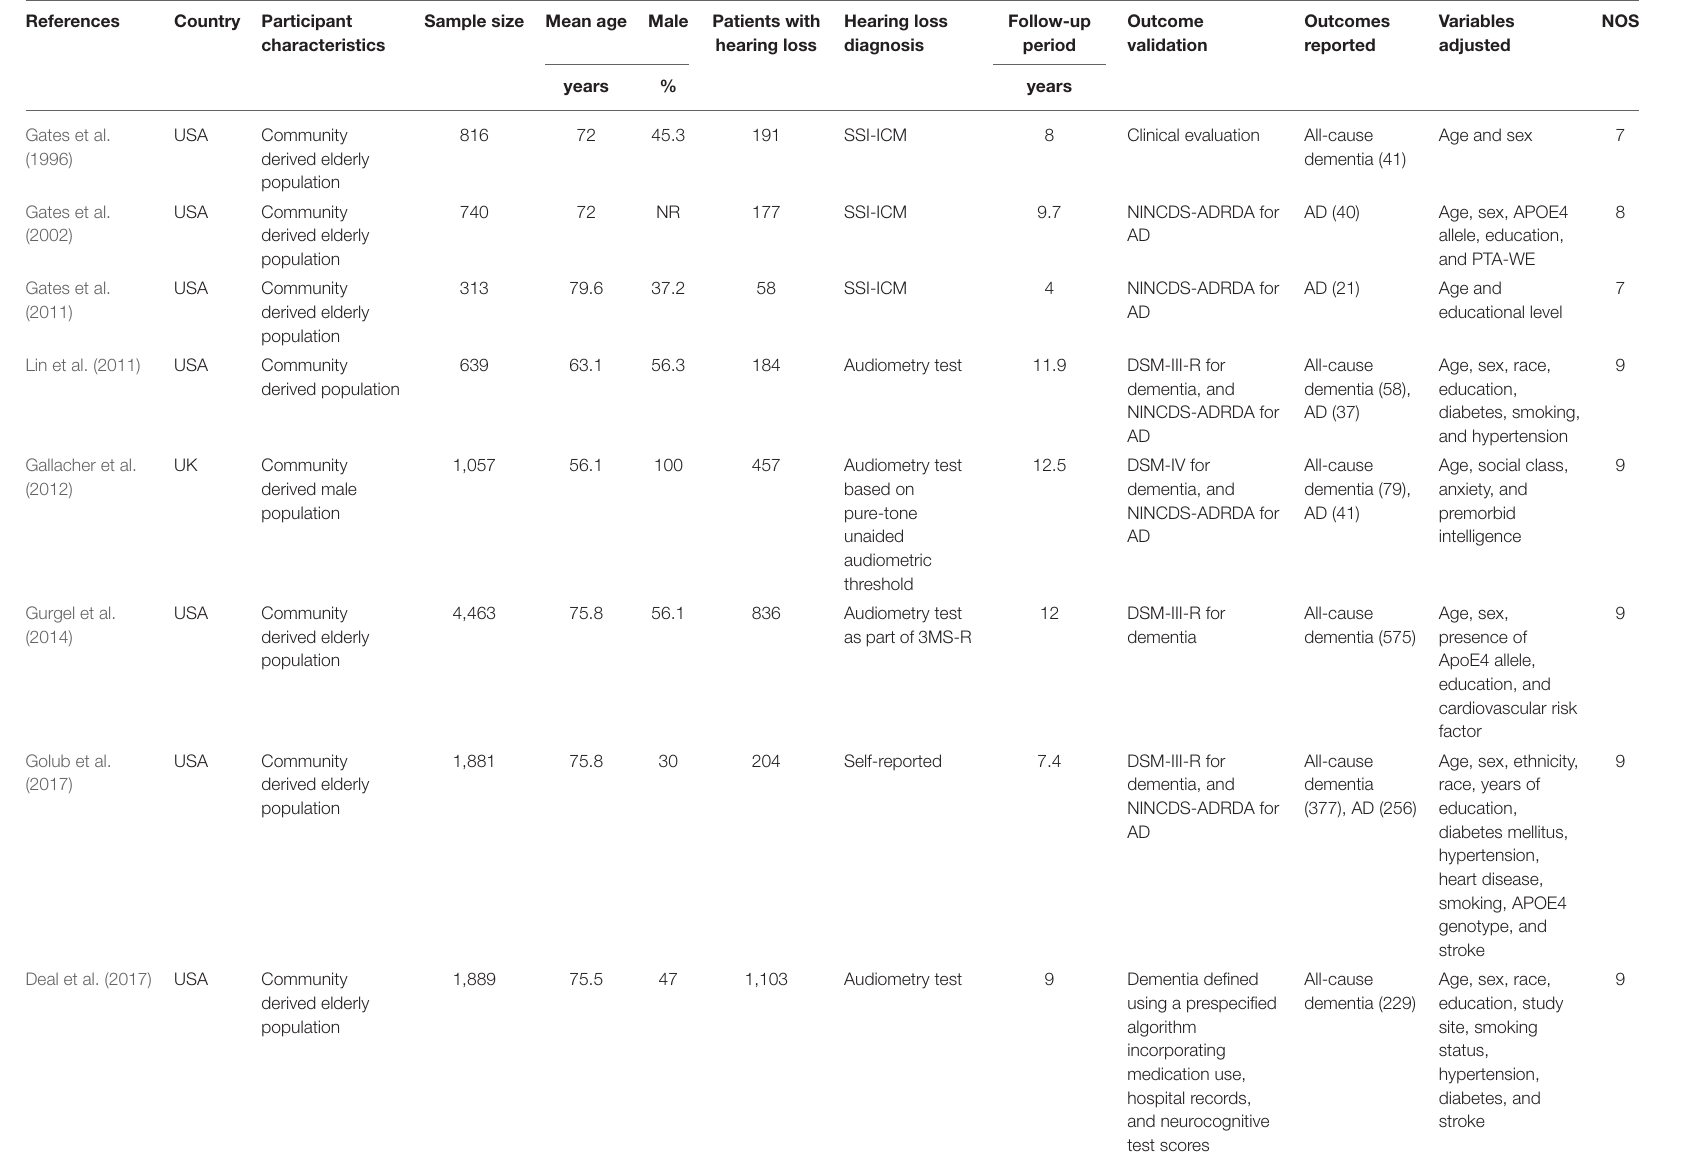
TABLE 1 | Characteristics of the included prospective cohort